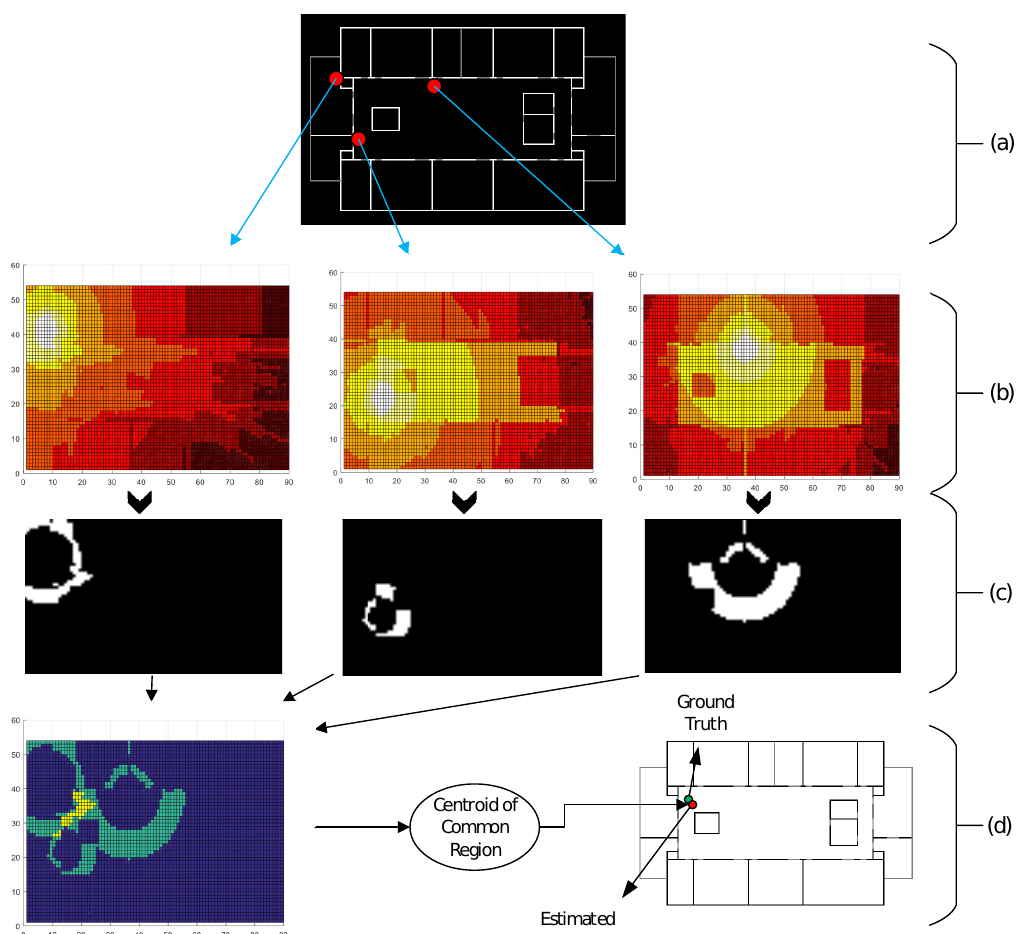
Figure 5. Details of the 3rd task for target location estimation: ( a ) location of the selected APs with the strongest RSSI received by the target/user, on the map; ( b ) radio-map of each selected AP; ( c ) binary map obtained after applying the threshold value, depicting the expected region around an AP, where the target is located; and ( d ) intersection of the binary maps and location, considering the centroid of the common